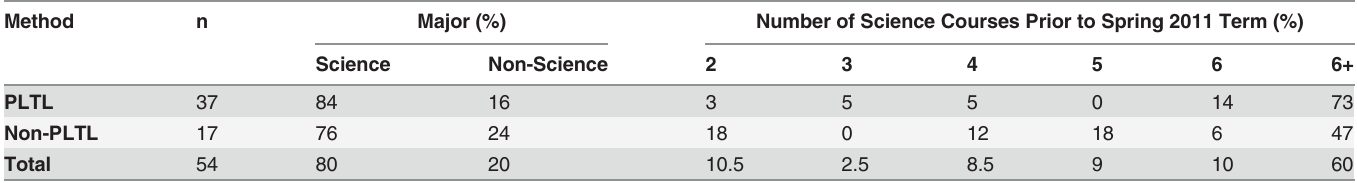
Table 3. Major and Number of Science Courses taken Prior to Spring 2011 for PLTL and Non-PLTL Groups.